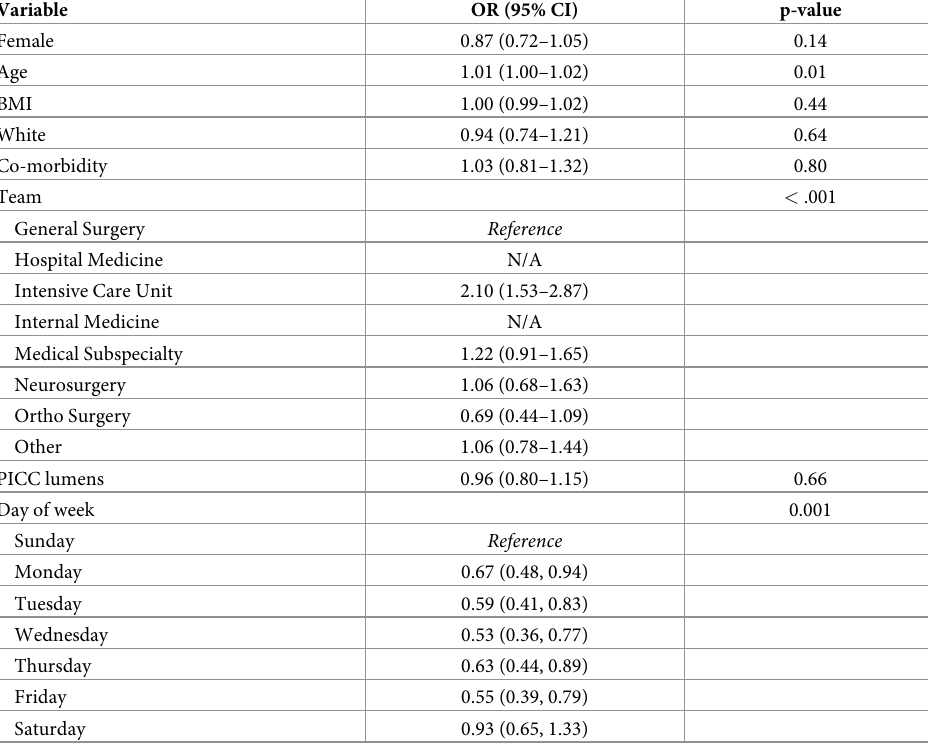
Table 3. Multivariable model assessing associations with early PICC removal using the EHR data.